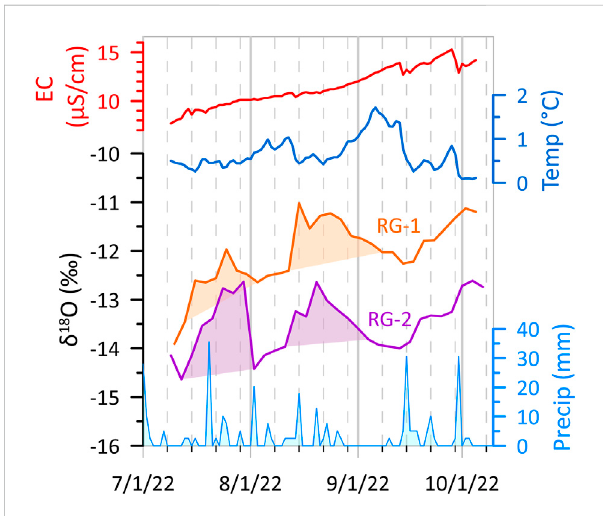
FIGURE 4 Timeline of δ 18 O values from the RG-1 and RG-2 water samplers inthe Uinta Mountains through themeltseasonof 2022. Both records contain two obvious spikes to less negative values that correspond with precipitation events at the nearby Chepeta SNOTEL site (bottom). Daily electric conductivity (EC) in µS/cm (red line) and water temperature (blue line) at RG-2 are also presented.